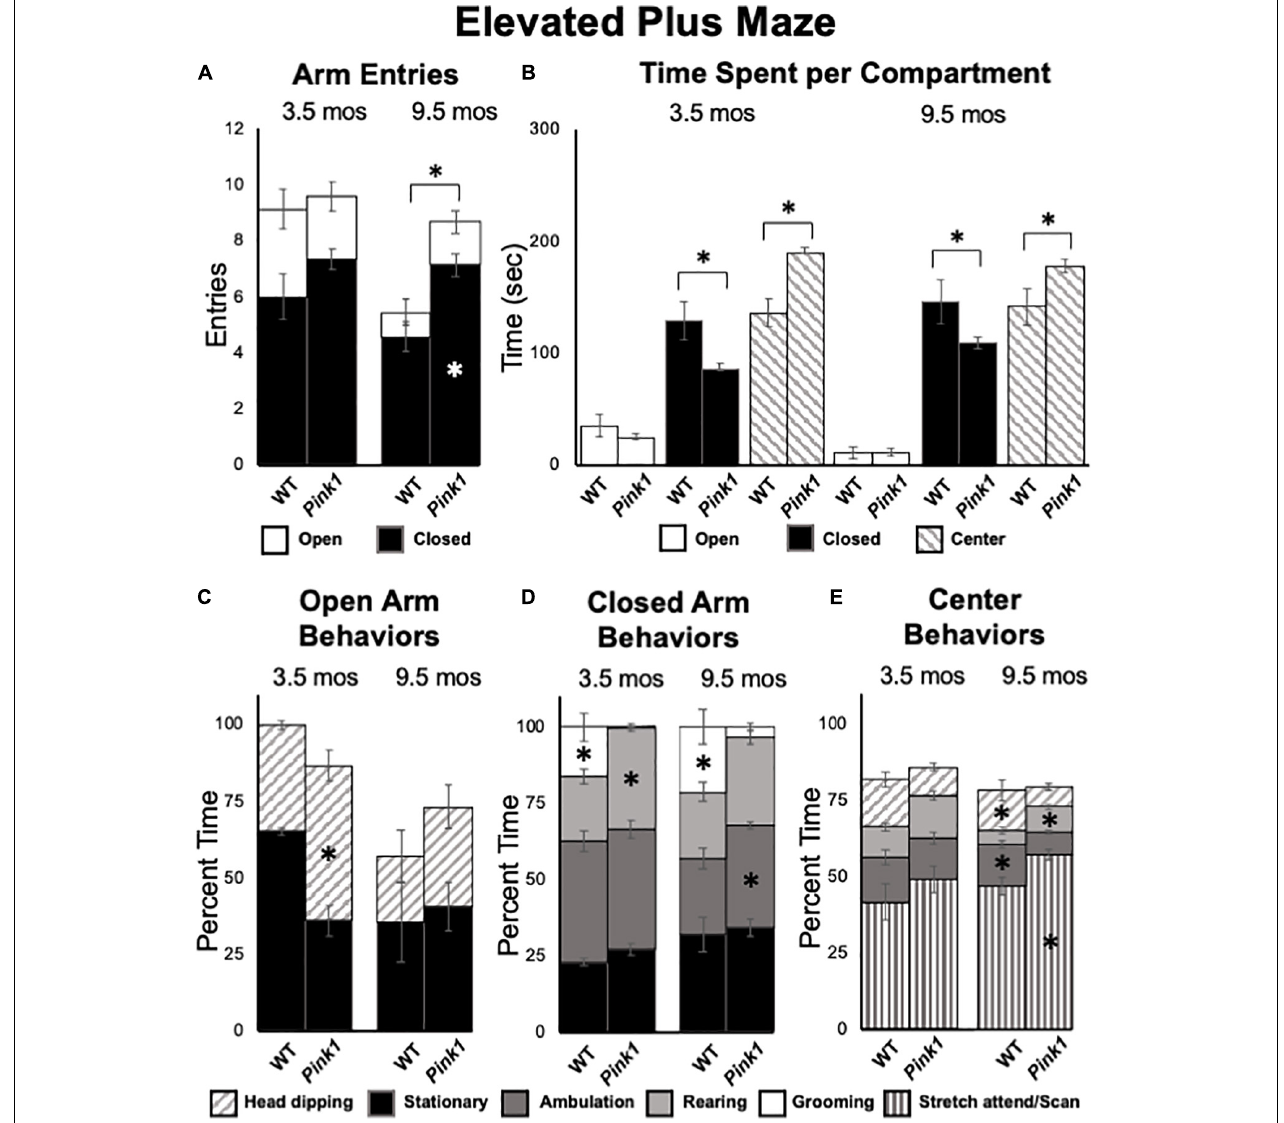
FIGURE 8 | Elevated Plus Maze data. (A) Stacked bar graphs showing total arm entries divided into total entries made into open (white) and closed (black) arms for wild type (WT) and rats with knockout of the PTEN (phosphatase and tensin homolog)-induced putative kinase1 gene ( Pink1–/– ) for testing at 3.5 and 9.5 months (mos) of age. The black asterisk shows that at 9.5 mos of age, rats in the Pink1 –/– group made significantly more closed arm entries than WT rats; the white asterisk shows that Pink1 –/– rats also made significantly more entries into closed arms than WT rats. (B) Bar graphs showing total amounts of time WT and Pink1 –/– rats spent in the open arms (white), closed arms (black) and the center platform (striped) of the maze during testing at 3.5 and 9.5 mos of age. Asterisks show that at both 3.5 and 9.5 months of age, Pink1 –/– rats spent significantly less time in closed arms and significantly more time on the center platform than WT rats. Stacked bar graphs showing percentages of total times Pink1 –/– and WT rats spent on major behaviors within the open arms (C) , closed arms (D), and center platform (E) during testing at 3.5 and 9.5 mos of age. Major behaviors examined included stationary behavior (black), ambulation (dark gray), rearing (light gray), grooming (white) head dipping (slanted stripes) and engaging in stretch-attend/scanning (vertical stripe) Significant group differences in the percentages of total times that rats devoted to a given behavior are marked by asterisks within the bar graphs of the group where significantly more time was